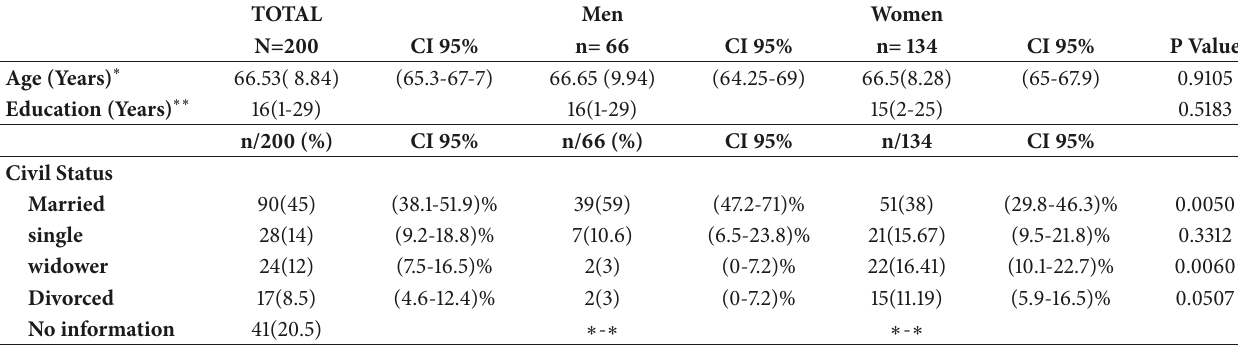
Table 1: Characteristics of the